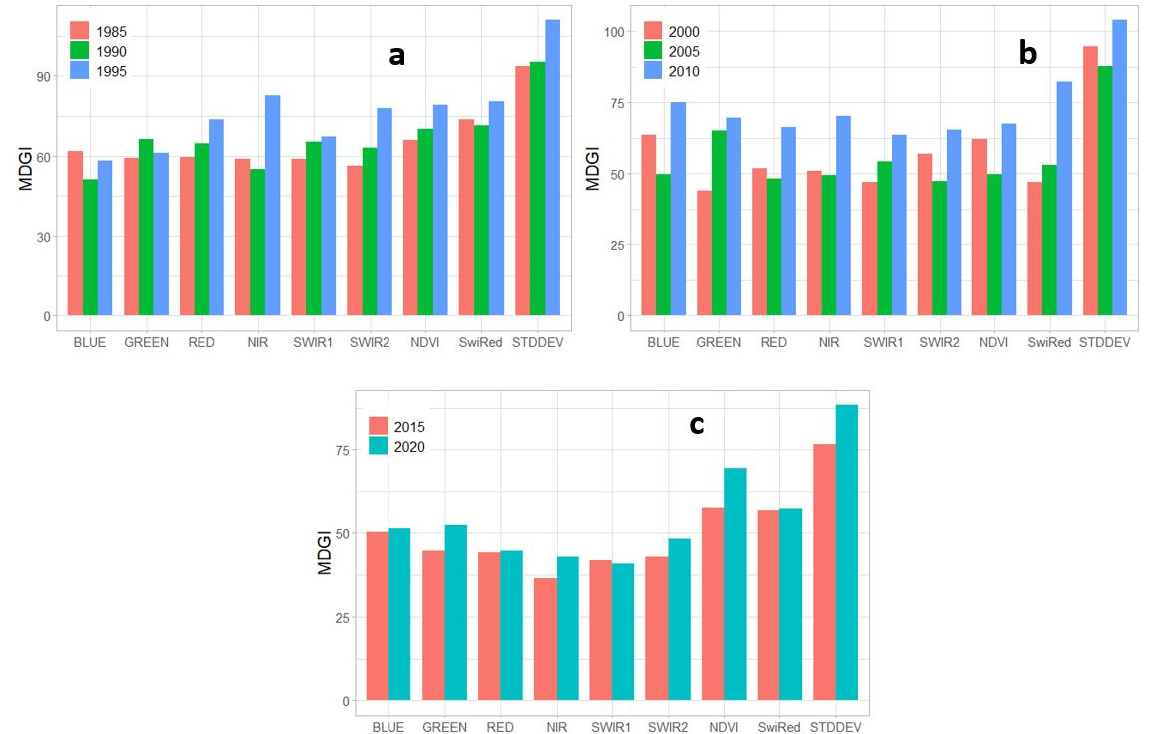
Figure 3. Median importance of the variable (MDGI) in the RF models, based on the D3 dataset, for Landsat -5 ( a ), Landsat -7 ( b ), and Landsat -8 ( c ). Landsat-5 ( a ), Landsat-7 ( b ), and Landsat-8 ( c ).